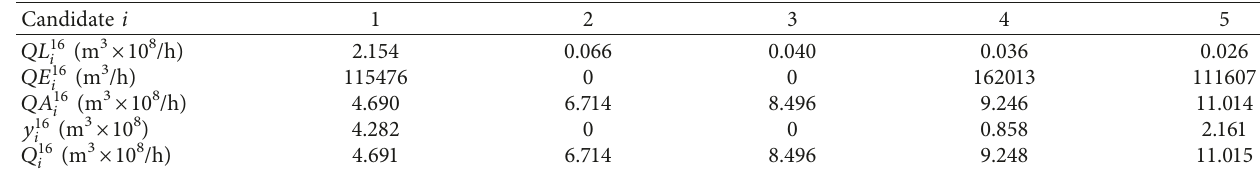
Table 13: Operational decisions under scenario 16.